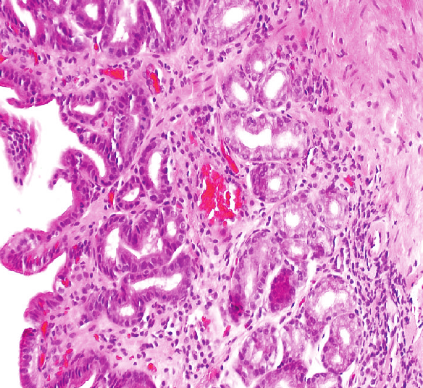
Figure 2: Inflammation at lamina propria and dilated capillary and